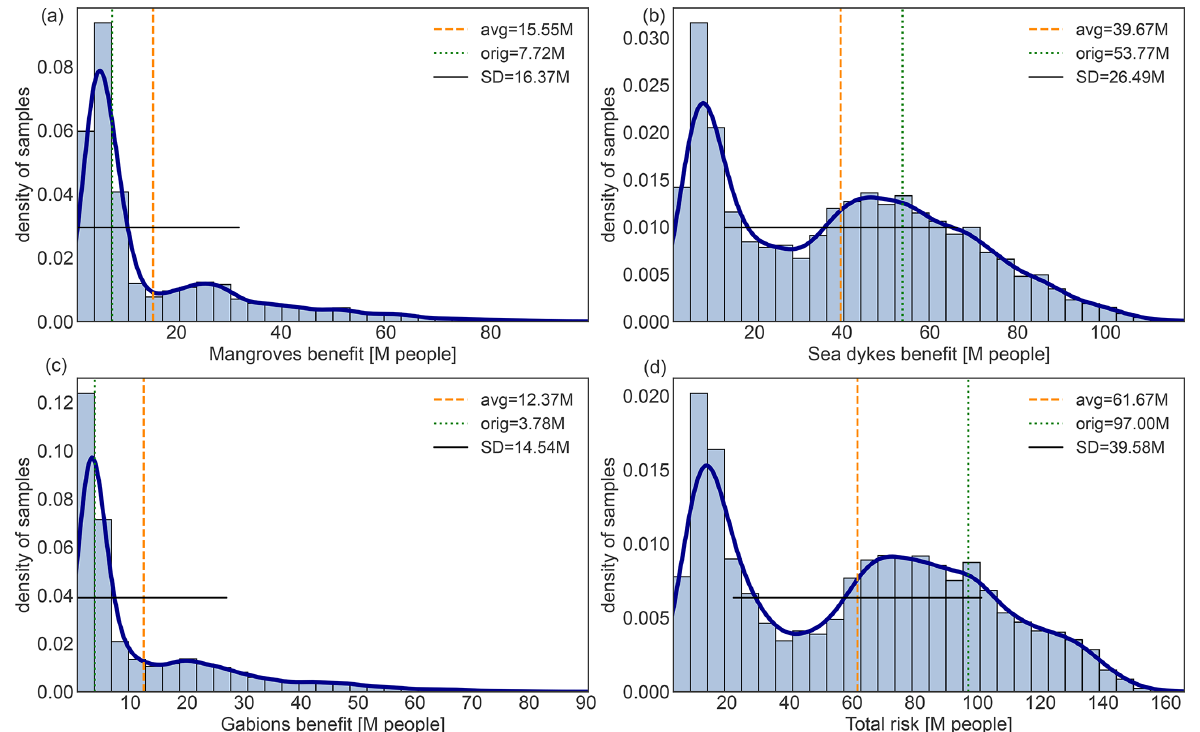
Figure 4. Uncertainty distribution (histogram bars) for benefits (averted risk) from the adaptation measures: (a) mangroves, (b) sea dykes, (c) gabions, and (d) the total risk without adaptation measures. Benefits and total risk are cumulative over the time period 2020–2050 for the climate-change scenario RCP8.5. Vertical dotted green lines indicate the case study value, vertical dashed orange lines show the average benefit over the uncertainty distribution, the horizontal solid black line shows the standard deviation, and the solid dark-blue line indicates the kernel density estimation fit to guide the eye. The benefits and total risk are expressed in millions (M) of affected